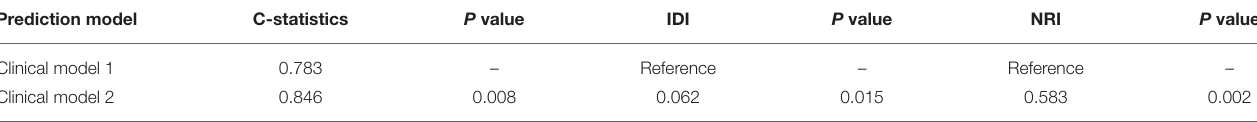
TABLE 5 | Prediction models for the presence of non-IR